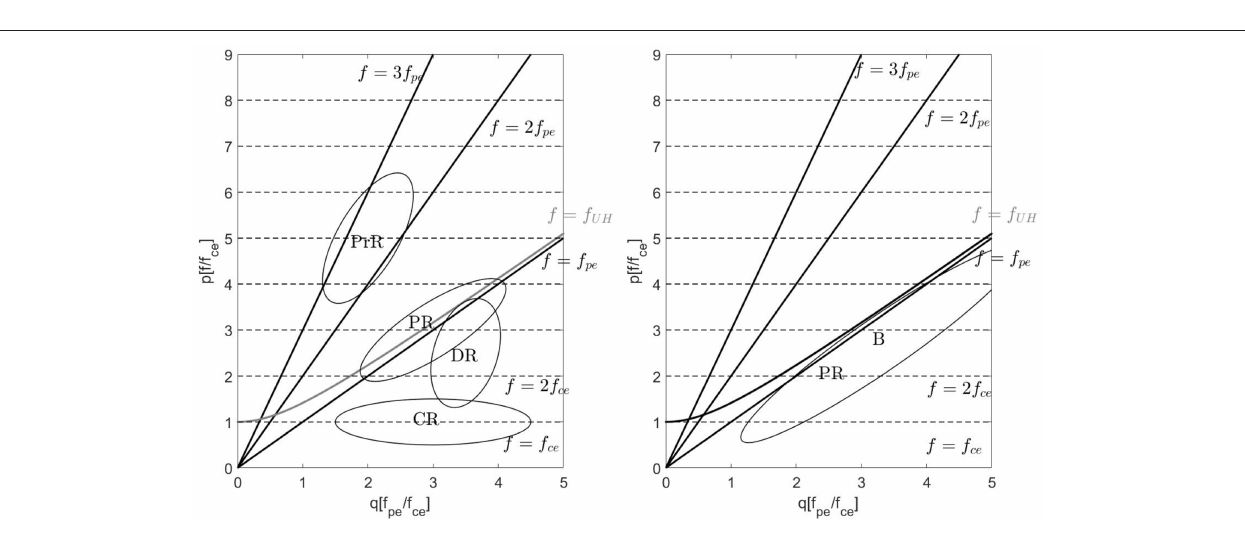
FIGURE 3 | Presentation of the SAP observations by Cosmos 1809 on the p − q diagrams ( p = f / f ce and f pe / f ce ). The selected areas show the locations of maximum electron (Left) and ion (Right) intensities together with the indication of the proposed acceleration mechanism. Electron acceleration models: cyclotron-resonance (CR) model (James, 1983), diffuse resonances (DR) model (Benson, 1982), plasma resonance (PR) model (Pulinets and Selegei, 1986), and parametric (PrR) resonance model (Serov et al., 1985). Ion acceleration models: plasma resonance (PR) model (Shuiskaya et al., 1990), wide-band acceleration (B) model (James, 1987). Local electron densities and magnetic fields are summarized in Table 3 . Adapted from Shuiskaya et al.